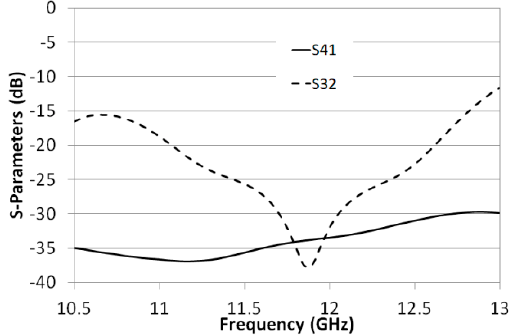
Figure 13. Experimental isolation of the Magic Tee prototype shown in Figure 11.